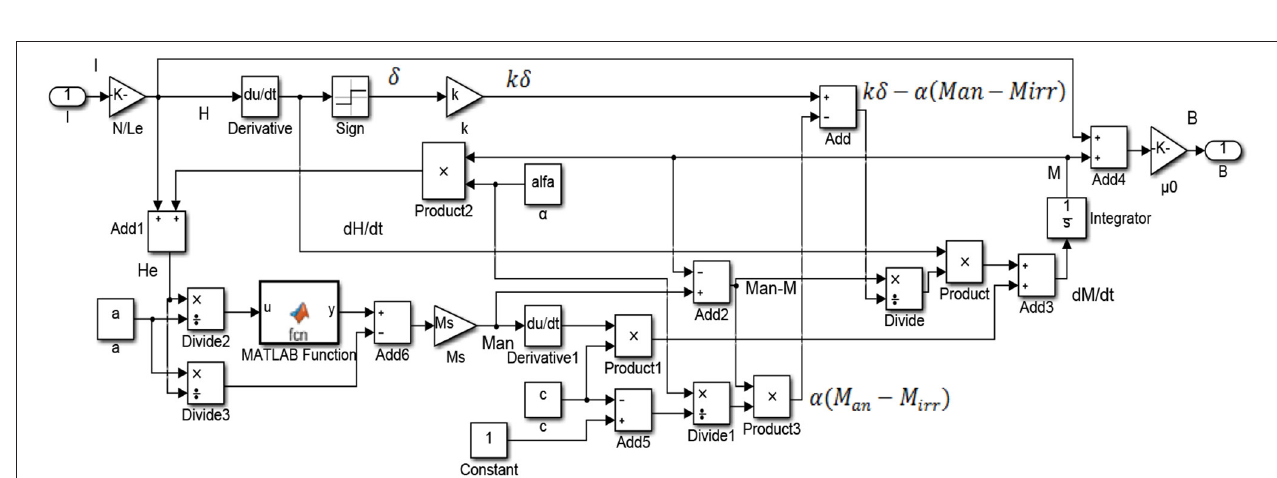
FIGURE 1 | Implementation of Jiles-Atherton model by